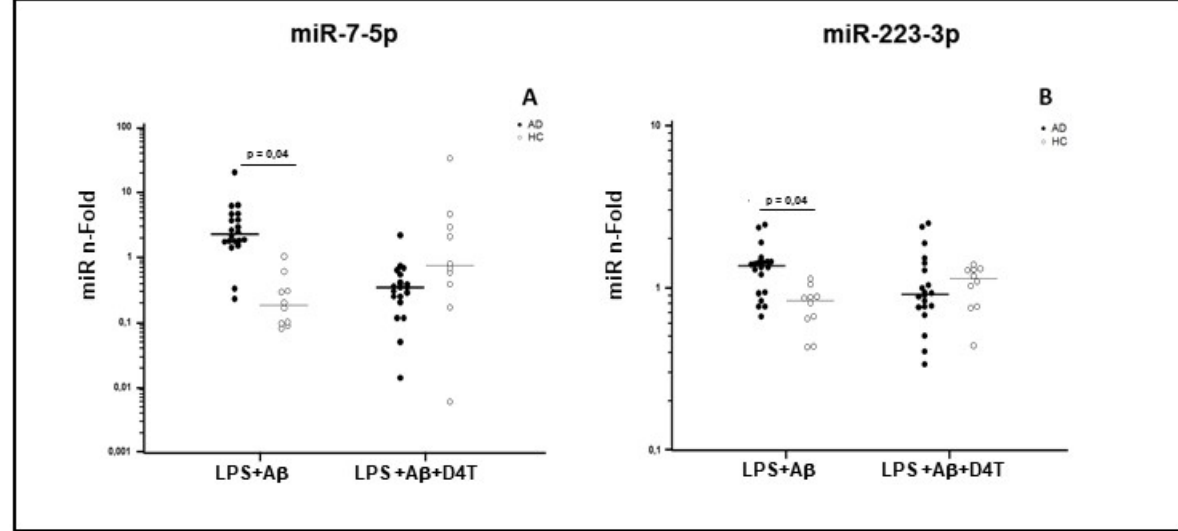
Figure 3. miR-7-5p ( A ) and miR-223-3p ( B ) concentration. Results were obtained after samples were primed with lipopolysaccharide (LPS) (1 µg/mL) and stimulated with A β 42 (10 µg/mL) in the presence/absence of D4T (Stavudine) (50 µM) PBMC of AD (black dots) patients and Healthy Controls (HC) (white dots). Summary results are shown in the dots-plot-graphs and are expressed as the fold change (n-fold) between results obtained in stimulated cells/medium (unstimulated cells). Row data were normalized relative to a reference miRNA (miR-103-3p). Horizontal bars indicate medians. Statistical significance is shown.